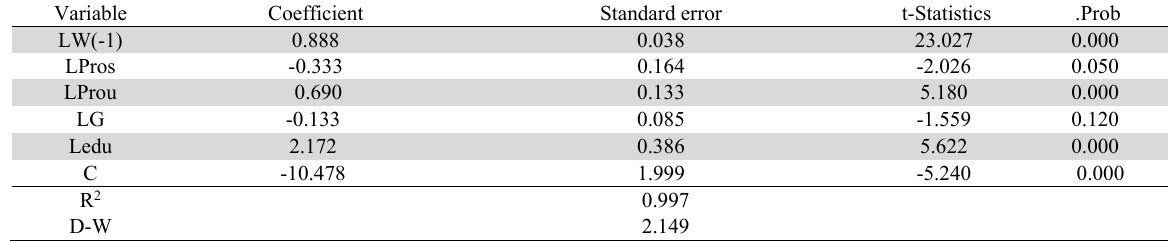
The short-run relationship between skilled and unskilled labor productivity and the level of wages without time trend